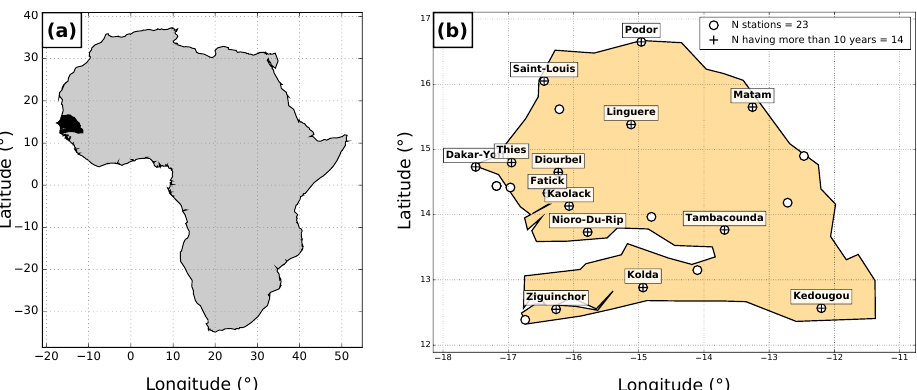
Figure 1. (a) The location of Senegal is indicated by the black area. (b) A map of Senegal. White circles represent tipping bucket rain gauges (a cross and a label are added for stations having more than 10 years of valid data).